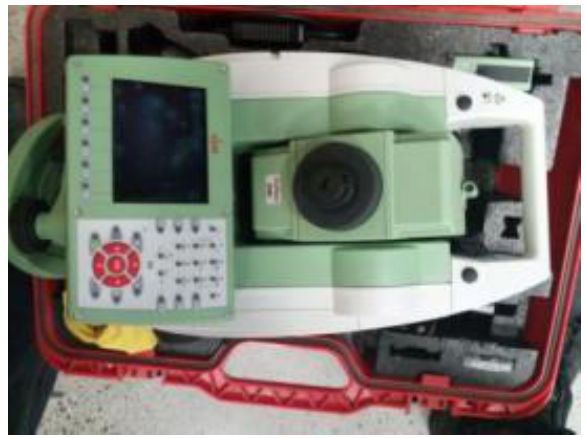
Figure 7. Leica viva TS11, Total Station. Photo: Pierre Jouan.